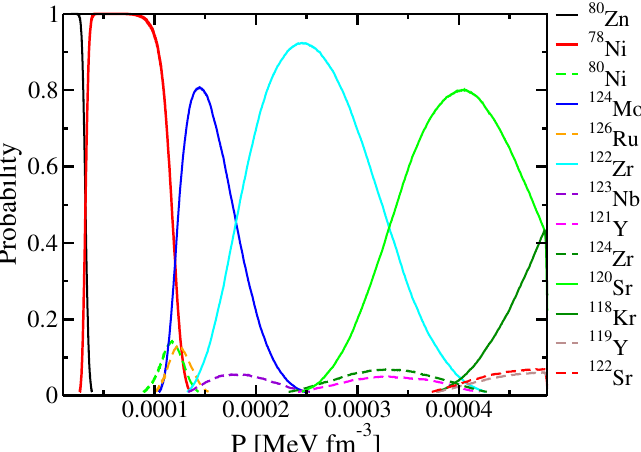
Figure 11. Colours online. Existence probability of a given nucleus within the outer crust as a function of the pressure, obtained via a Monte Carlo sampling using the DZ10-GP mass table. See text for details.